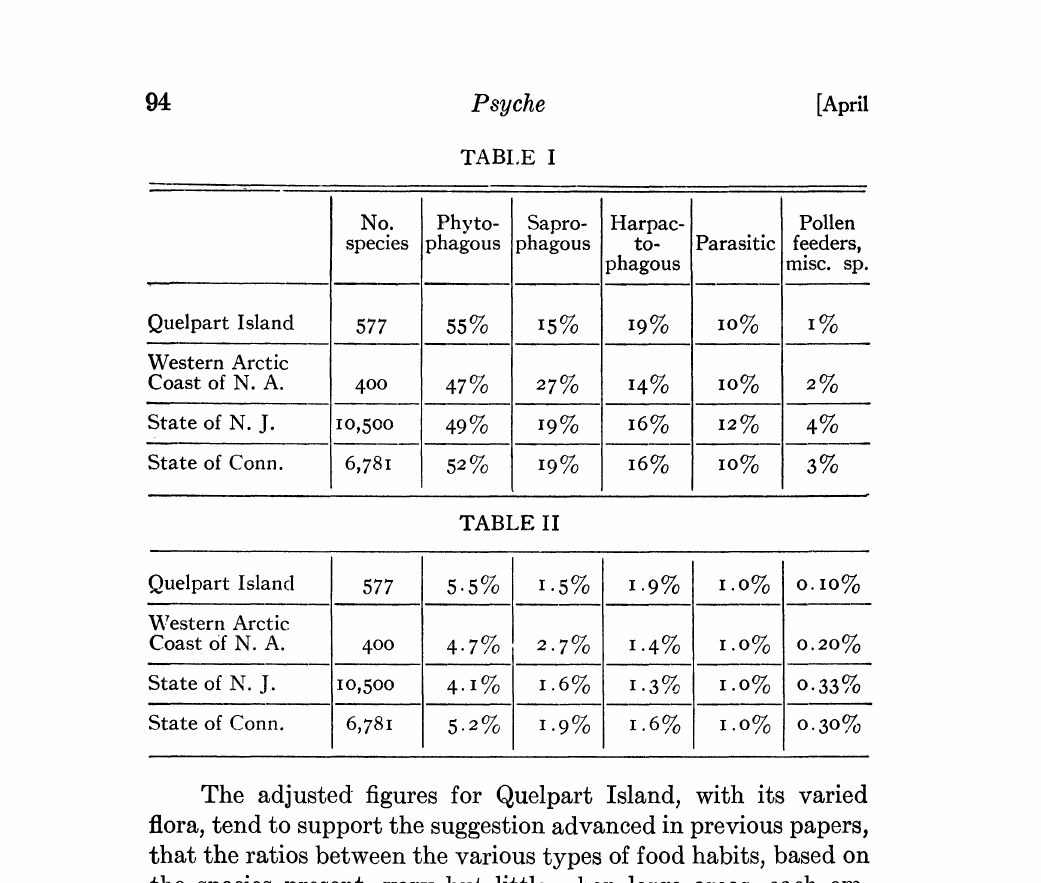
Quelpart Island Western Arctic Coast of N. A. State of N. J. State of Conn.